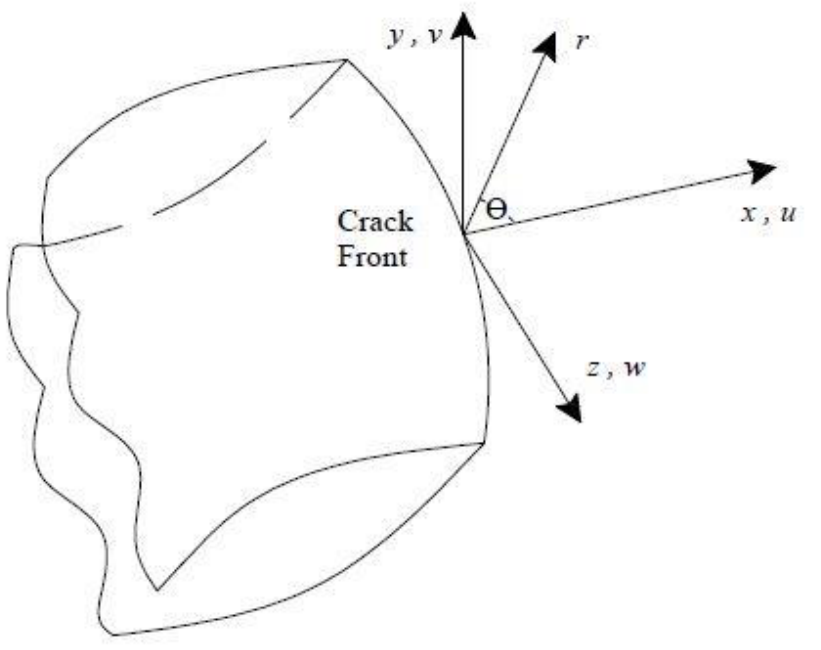
Figure 2. Local coordinate system of spatial crack front.